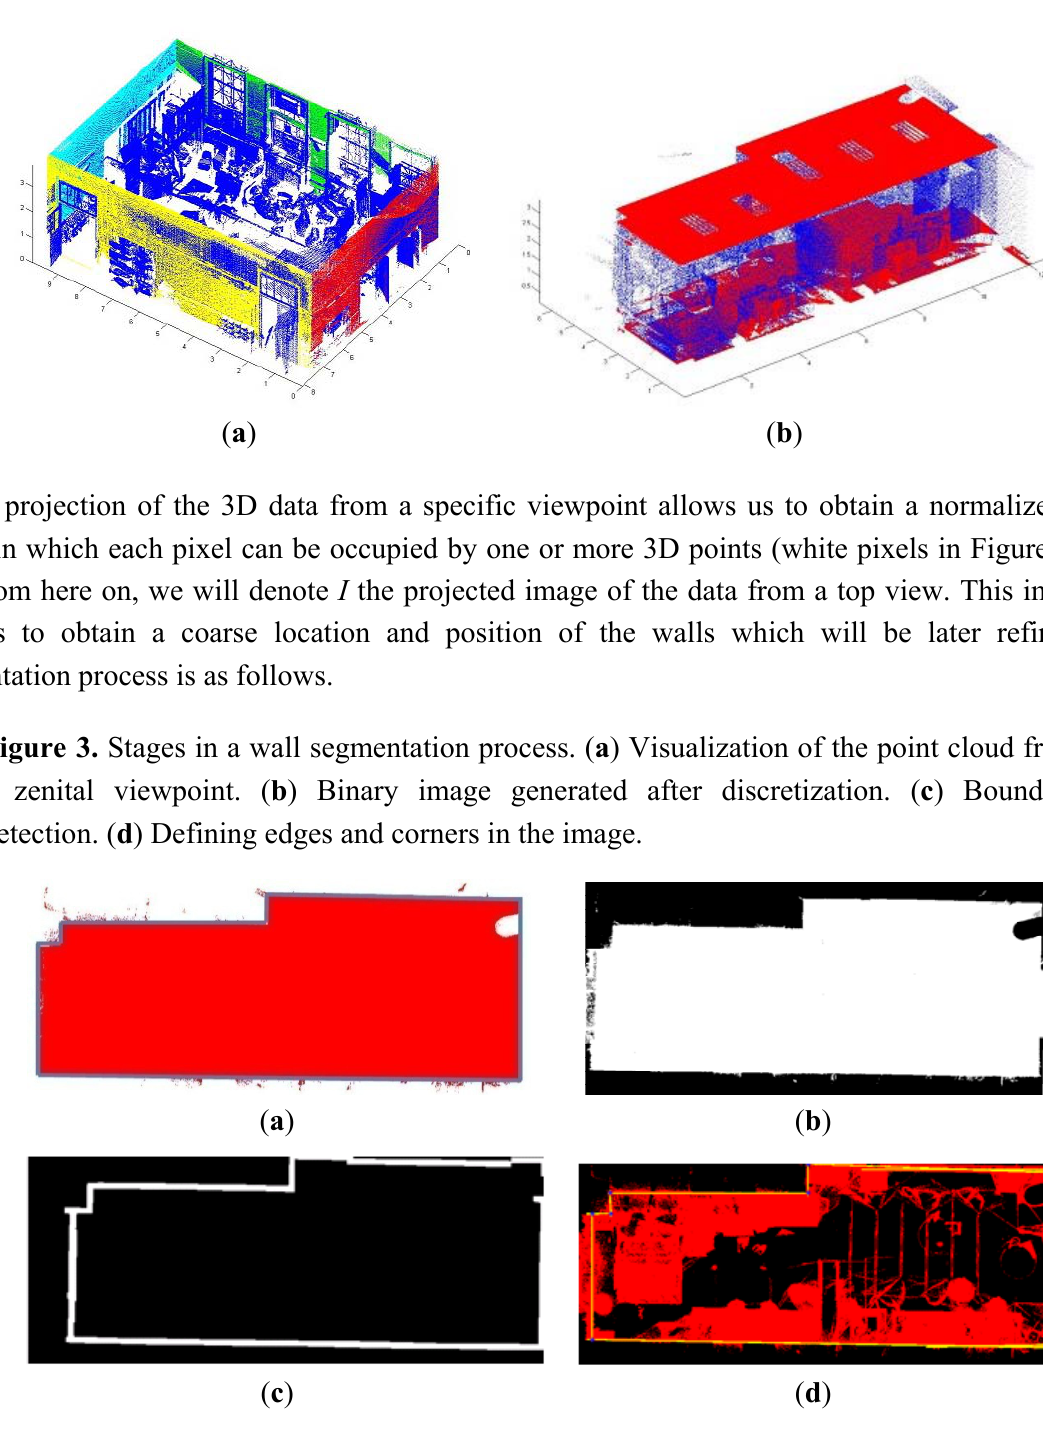
Figure 2. Segmentation of floor and ceiling in rectangular ( a ) and arbitrary ( b ) plans. (a) shows the segments of the four walls of the rectangular indoor presented in Figure 1(d).